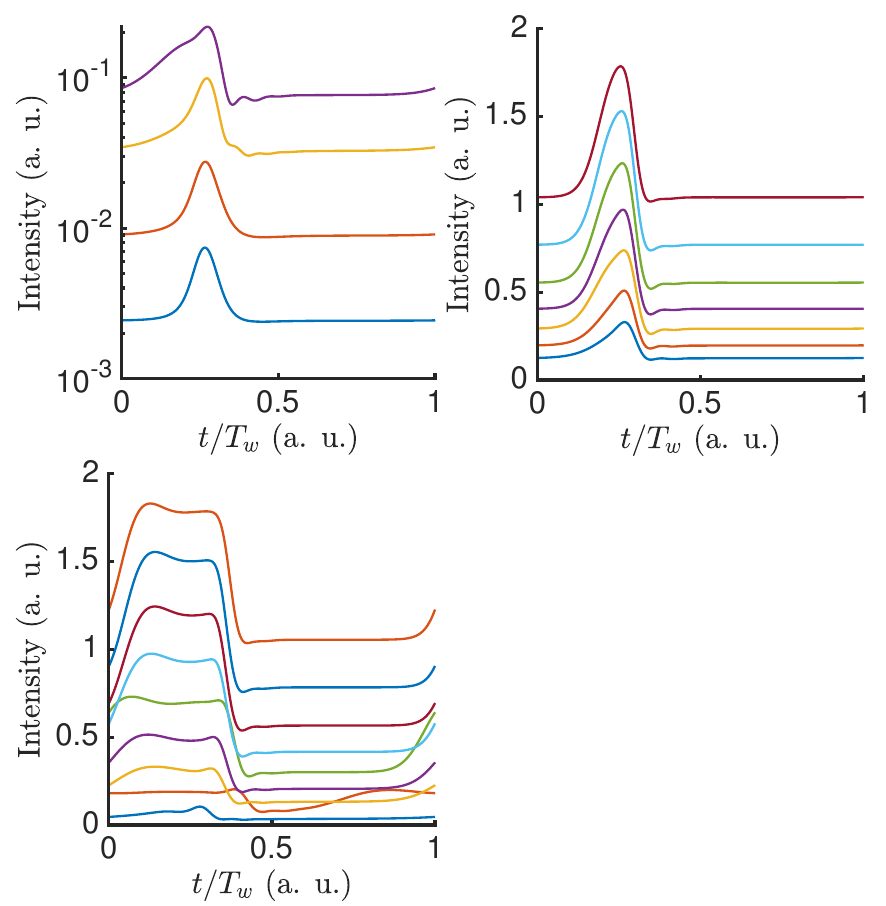
Figure 10. Top panels: Localized periodic solutions of Equation (12) from the middle points of the stable parts of the branches depicted on Figures 8 and 9 for ε increasing from 0.05 (bottom curve of the left upper panel) to 1 (top curve of the bottom panel). Bottom panel: Wider localized solutions from the secondary parts of the periodic solution branches for ε increasing from 0.2 (bottom curve) to 1 (top curve). Time is scaled by the solution period T w ∼ ε − 1 , which is controlled by the delay time T . Other parameters are as in Figure